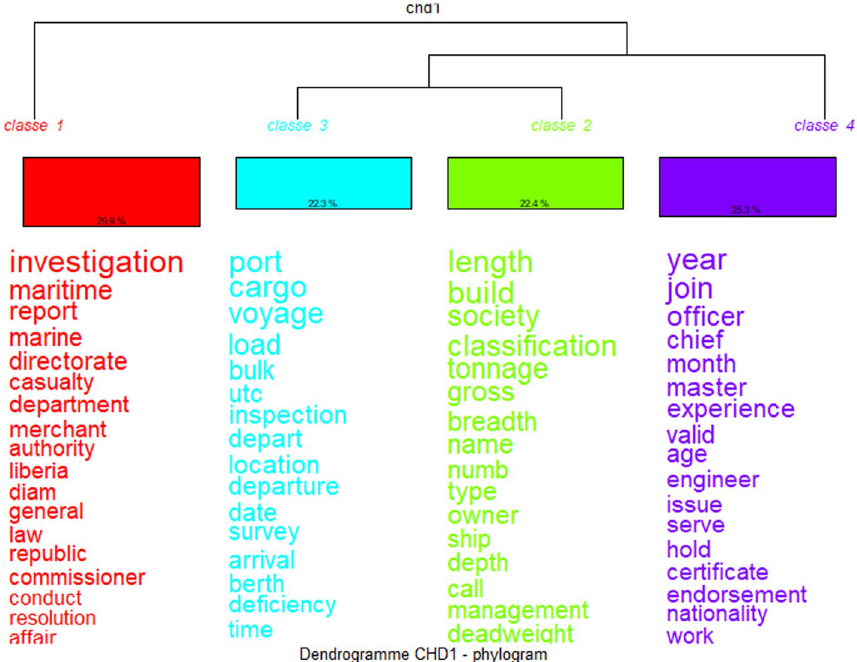
Fig. 6 Dendrogram of clusters extracted from the sub‑corpus of cluster 4 and associated word extracts (DHC) in IMO dataset. (* Cluster is reported as Classe in IRAMUTEQ dendrogram). Source: The authors